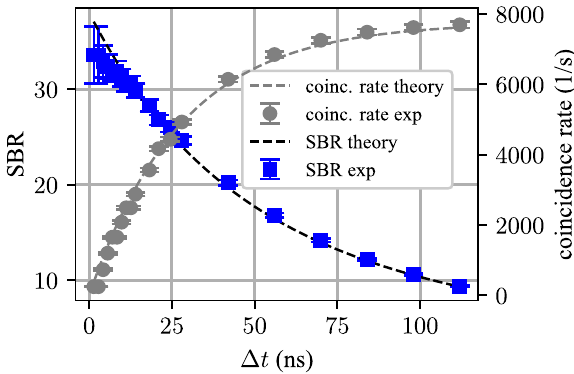
Fig. 3 Signal-to-background ratio and coincidence rate of the photon pair source. The SBR and the coincidence rate are plotted in dependence of the coincidence time window Δ t , for a pump power of 20 mW. The error bars are calculated from the Poissonian noise of the measured coincidences. The dashed lines show the theoretical calculations according to Eq. (4) for the SBR and Eq. (2) for the the only fi t parameter for coincidence rate, with R pair ¼ 4 : 7 (cid:3) 10 4 pairs smW both